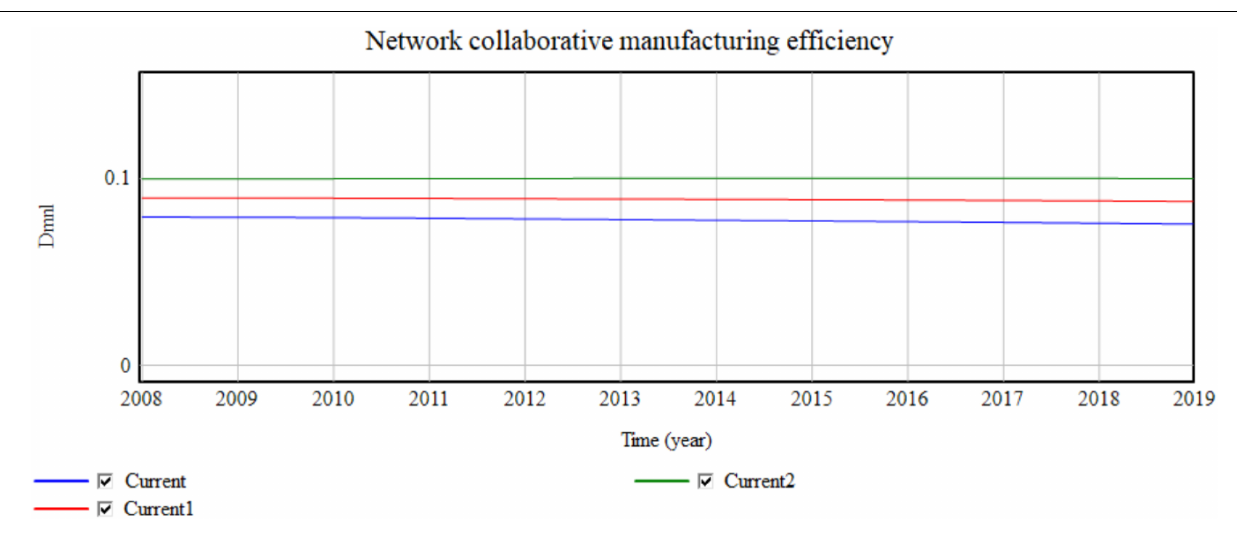
FIGURE 10 | Impact of micro science and technology innovation investment on network collaboration